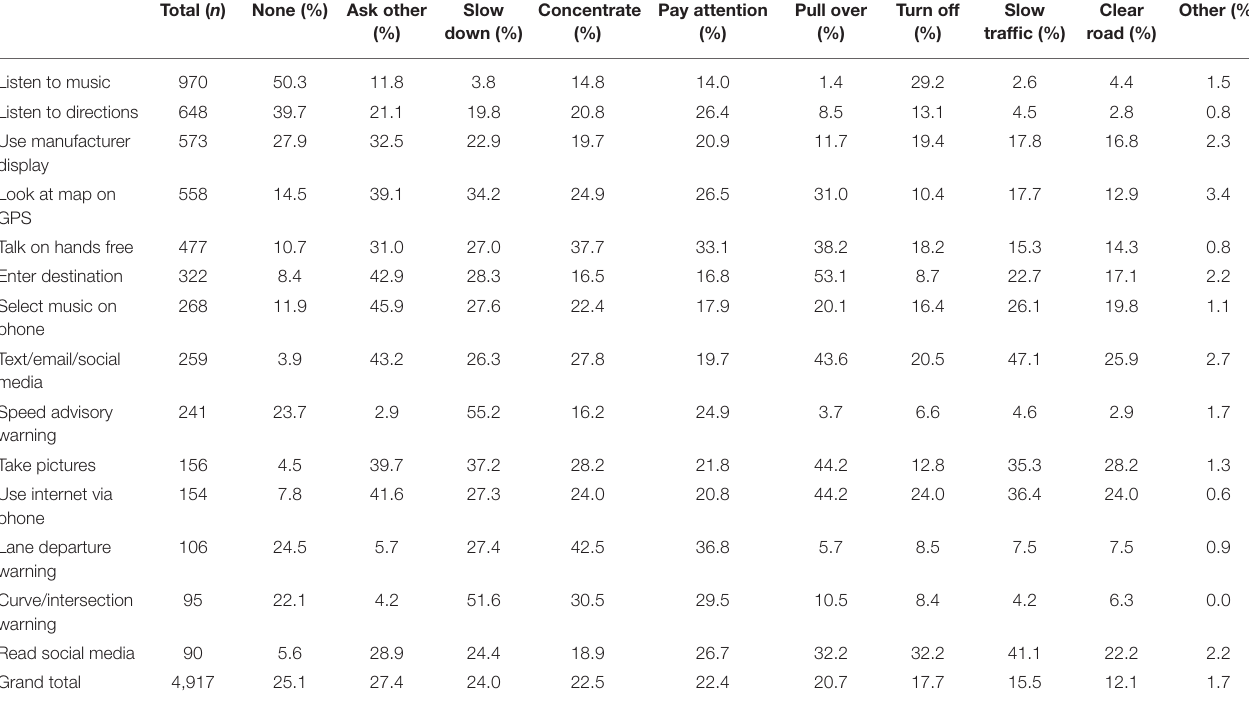
TABLE 7 | Countermeasures used for each behavior or event. Total ( n